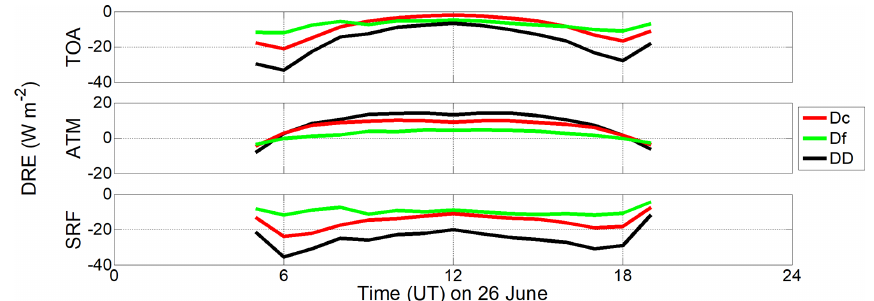
Figure 9. Diurnal cycle on 26 June (UT stands for UTC) in BCN of the dust direct radiative effect DRE (bottom) on the surface (SRF), (centre) in the atmosphere (ATM), and (top) at TOA. The daily mean AOD 440 for Dc and Df particles is, respectively, 0.19 ± 0.02 and 0.06 ± 0.02; SSA 440 is taken as constant at 0.94; asyF 440 is also taken as constant but is different for both modes: 0.865 and 0.629 for coarse and fine modes,